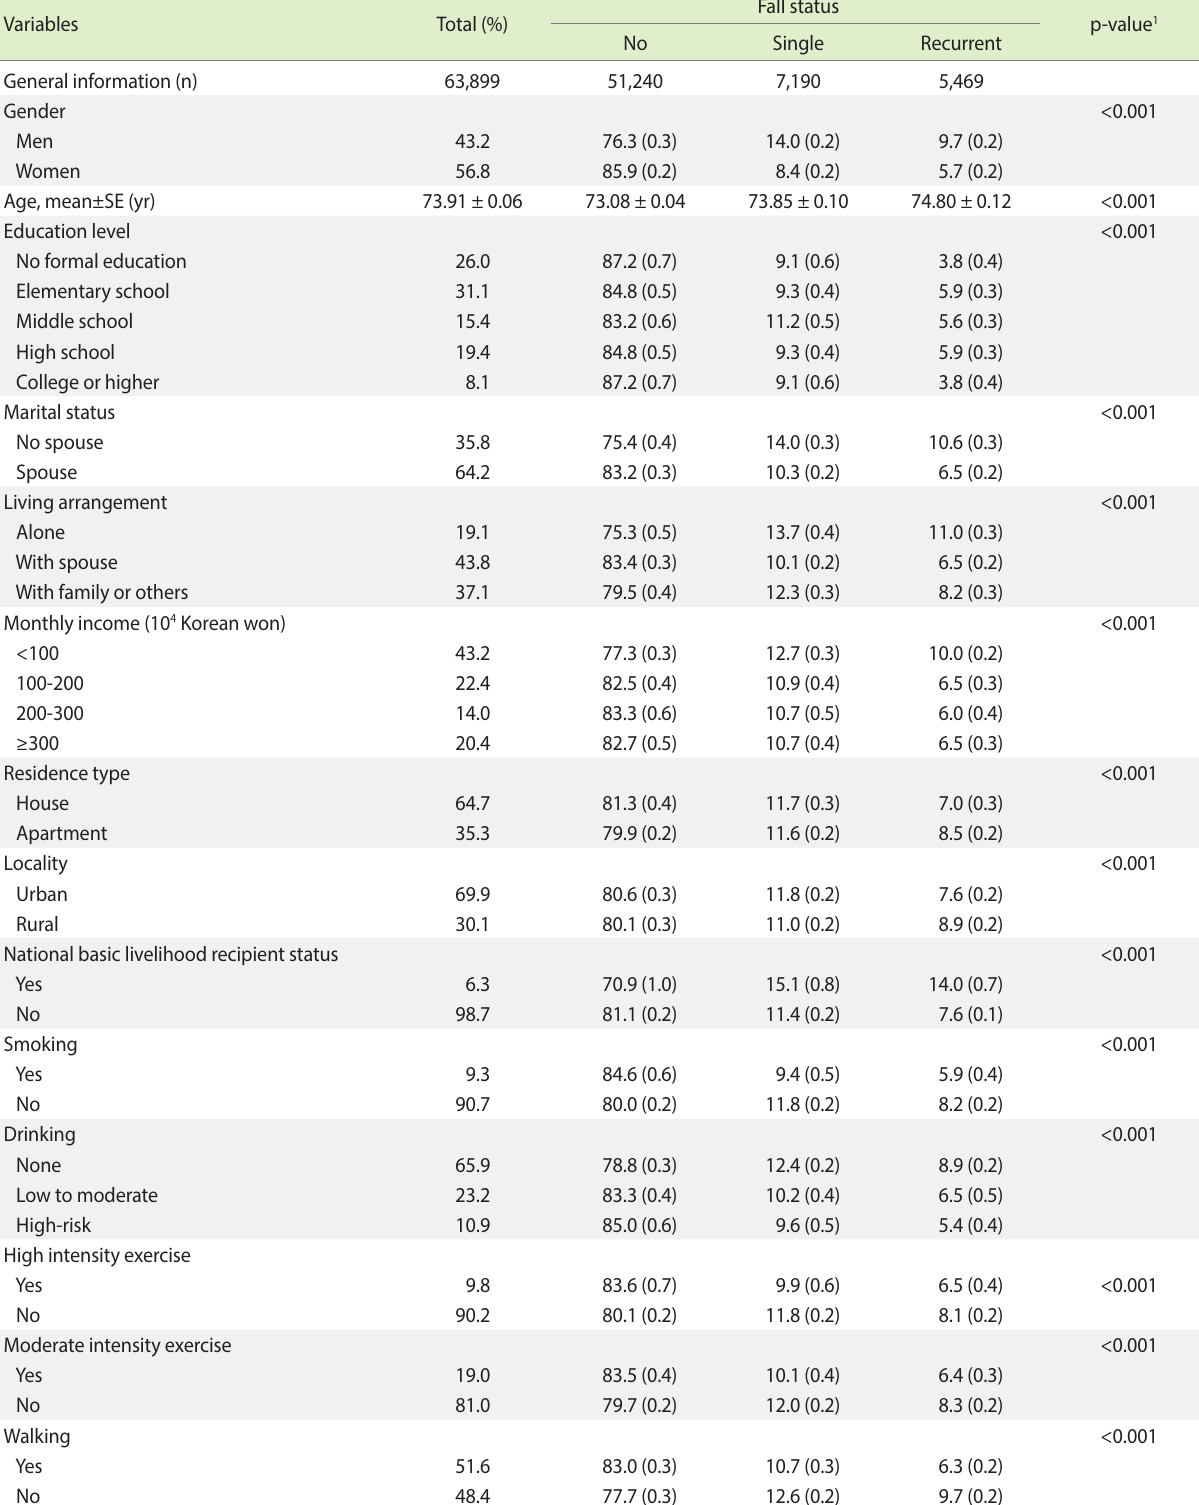
Table 3. Differences in general characteristic and health behaviors by fall status in adults aged 65 and older